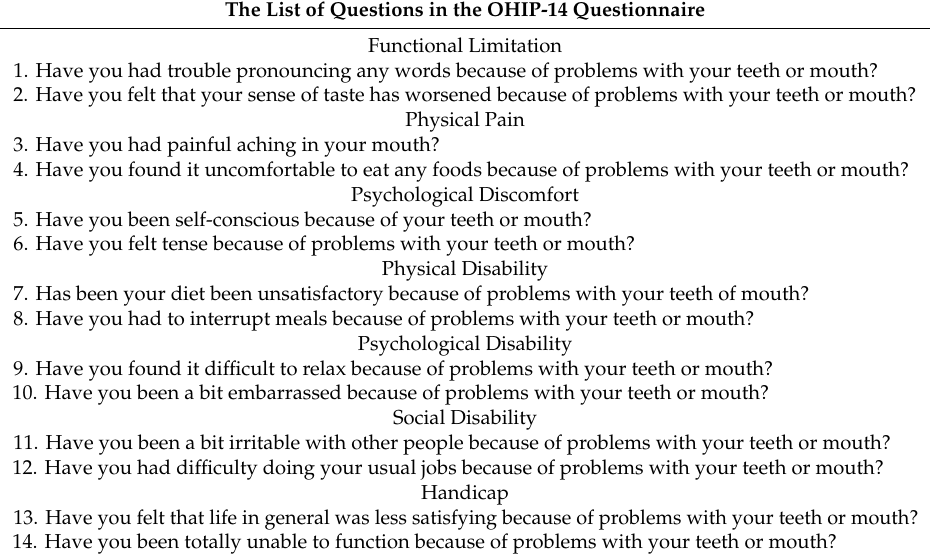
Table 3. The 14-item Oral Health Impact Profile (OHIP-14) Questionnaire